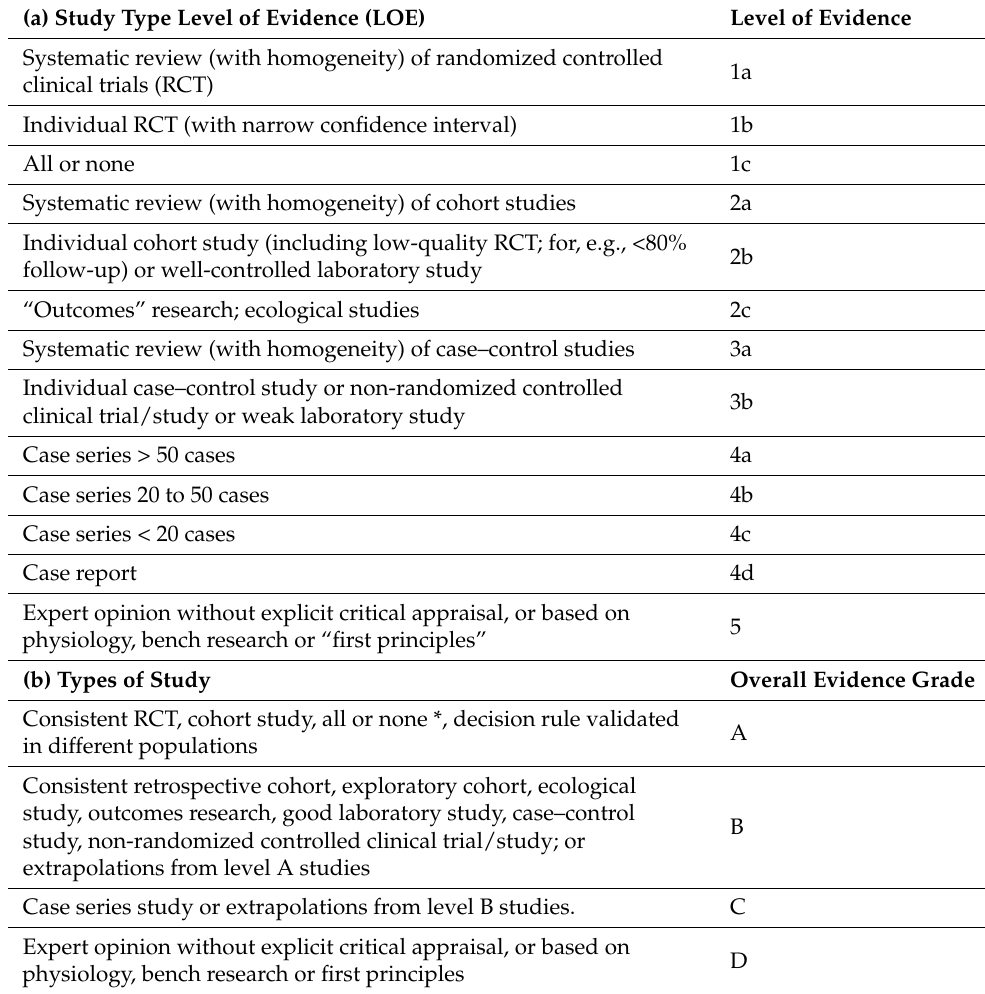
Table 1. Format used to grade ( a ) individual references and ( b ) overall level of evidence. Adapted from Elwood and others 2010